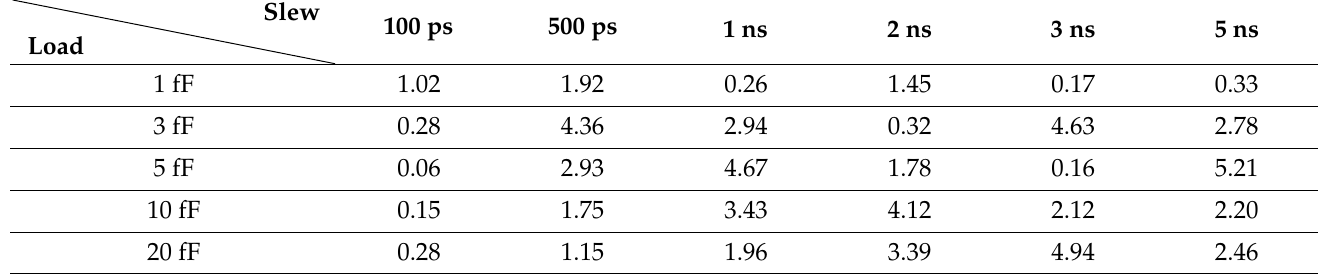
Table 2. Standard deviation error with the proposed model for NAND (%).